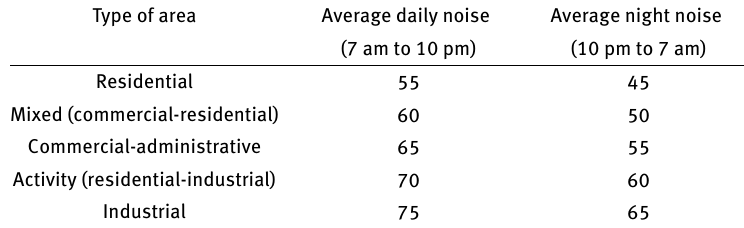
Table 6: Laws related to noise and noise pollution in Iran Tittle